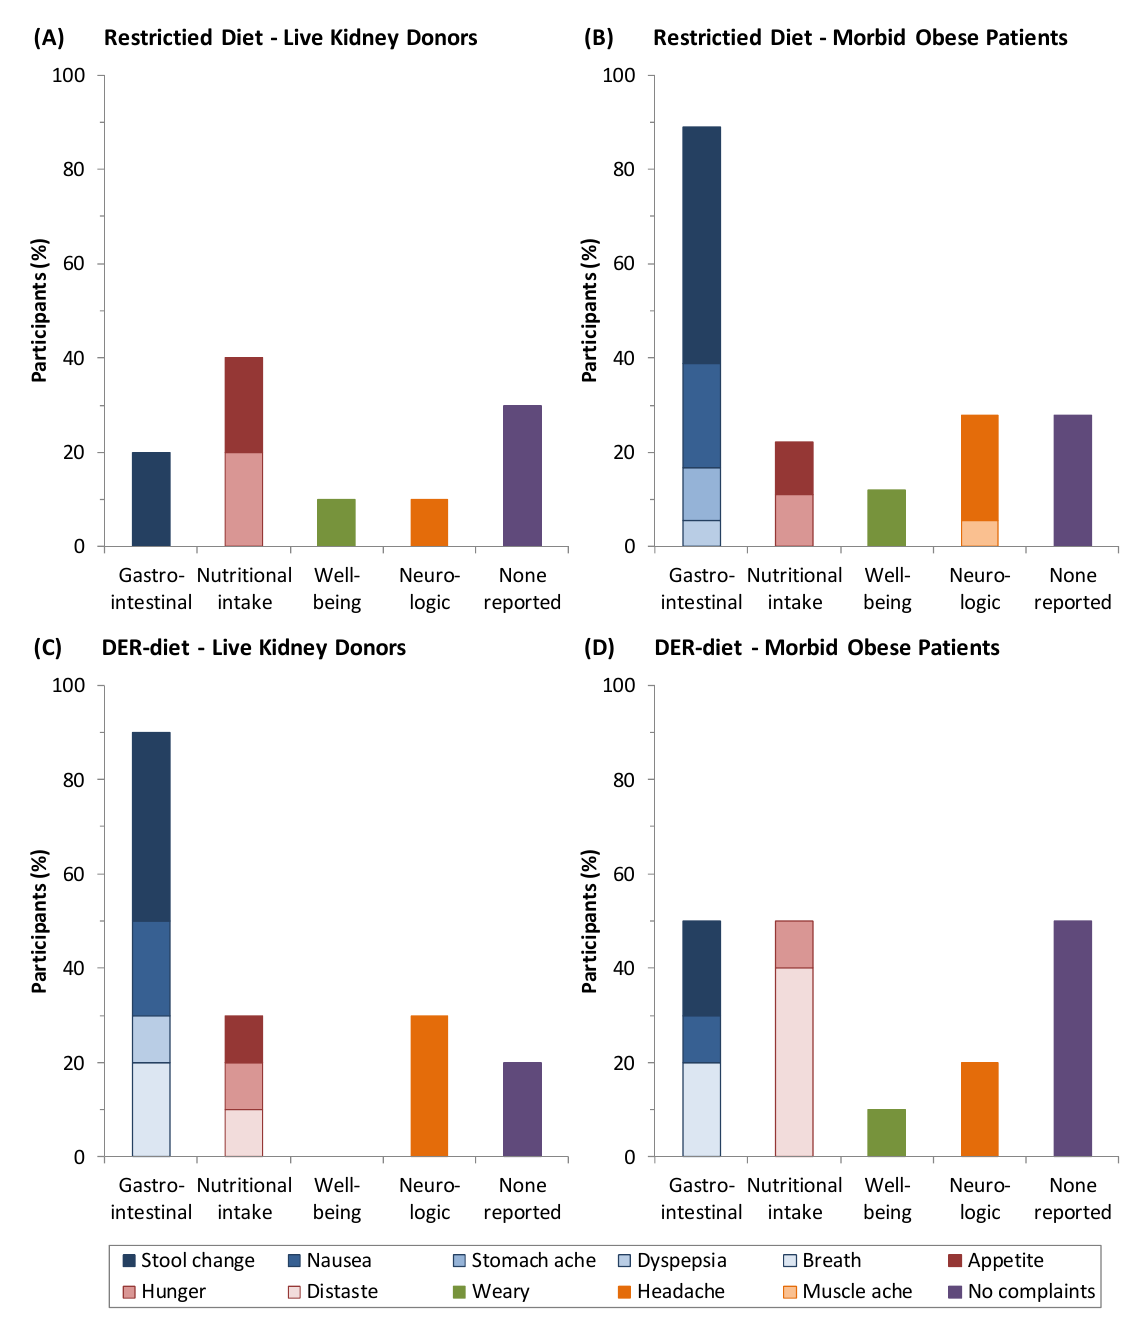
Figure 1. The number of side effects as percentages of participants in groups consuming a restricted diet and a daily energy requirements diet (DER-diet). ( A ) Side effects of the dietary restriction and protein restriction diet in the kidney donors were mostly related to nutritional intake and to the gastrointestinal tract; ( B ) Morbidly obese patients showed relatively more gastrointestinal discomfort; ( C ) A total of 90% of the kidney donors reported gastrointestinal discomfort during the DER-diet; ( D ) This percentage was lower in the morbidly obese patients and was the same as discomfort related to nutritional intake. Effects are clustered based on the origin of the symptoms. Within each cluster, each side effect is depicted in a different shade of color.